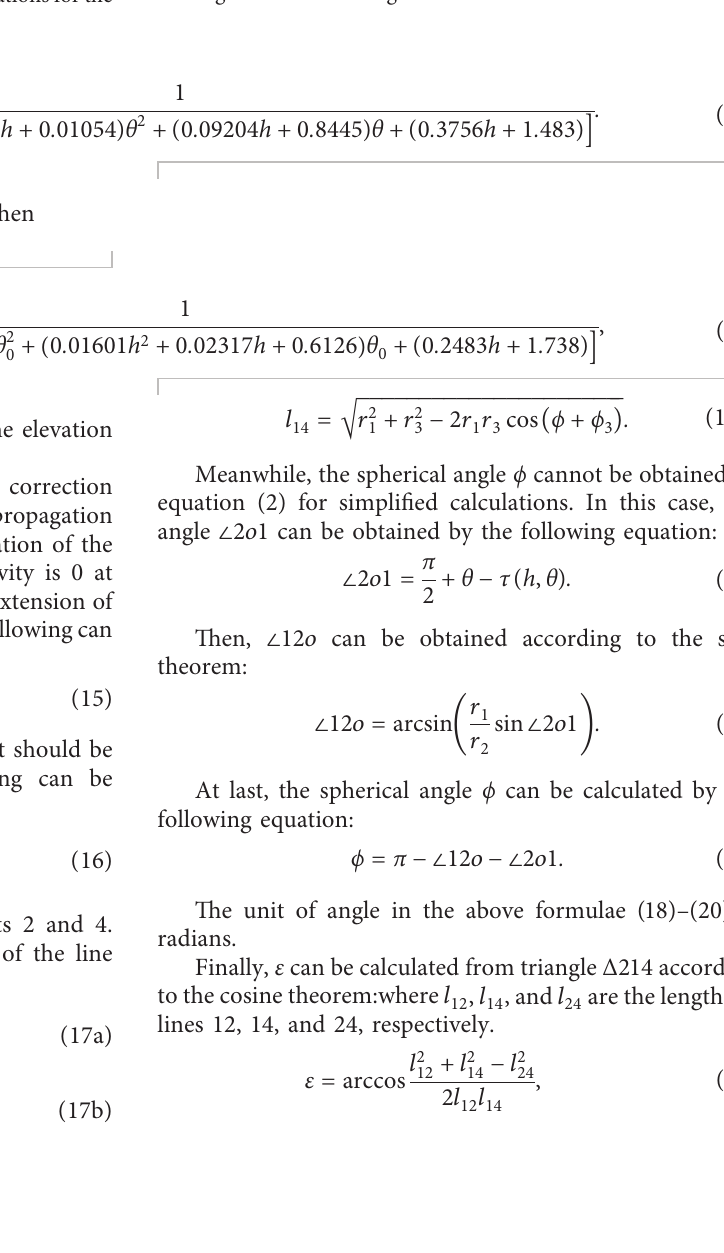
Figure 3: Schematic presentation of the atmospheric refraction for the negative elevation